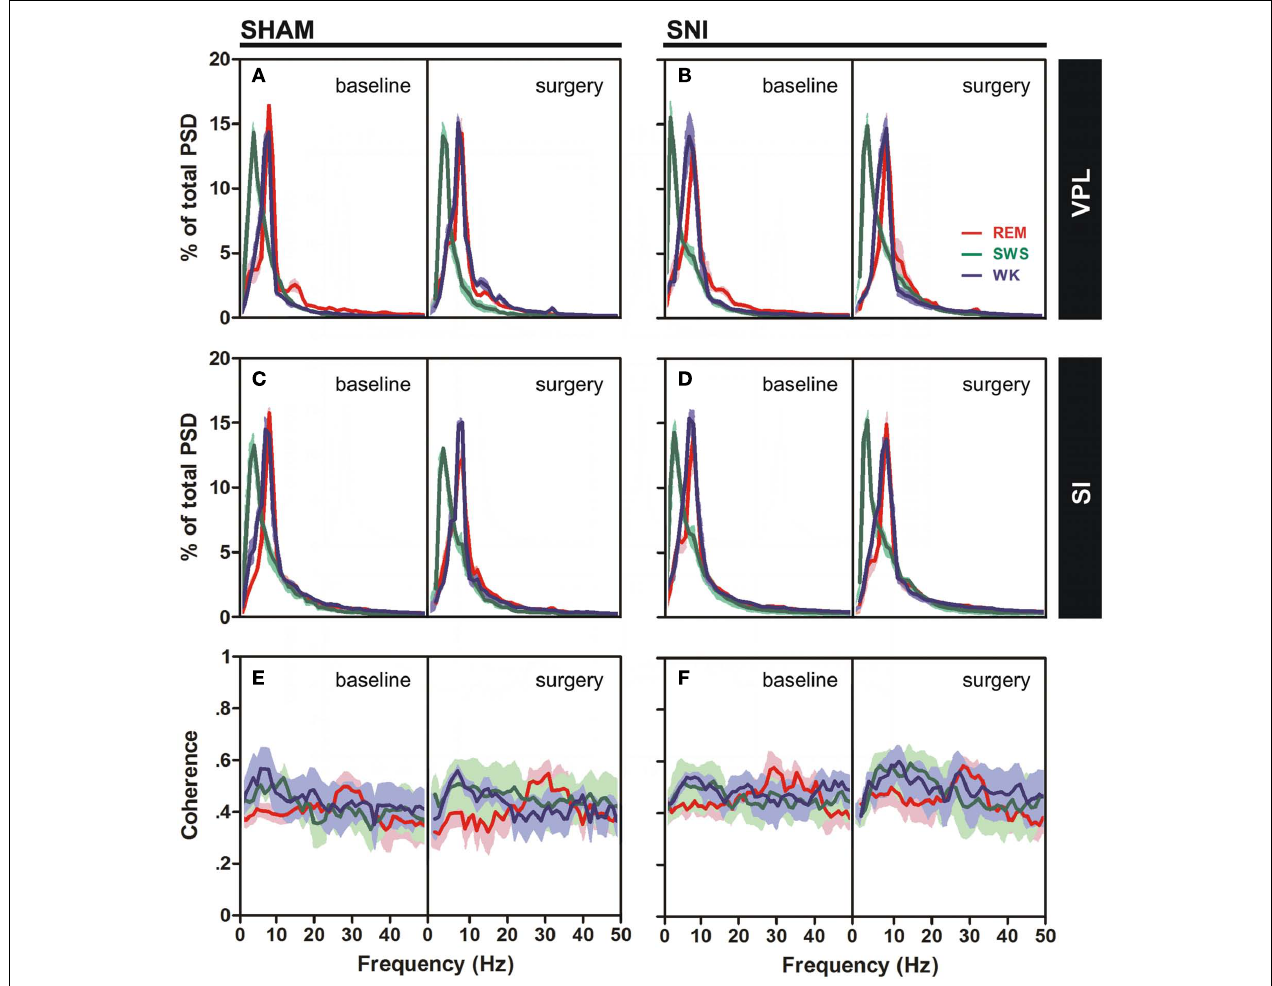
within the frequency range analyzed (1–50Hz) forVPL (A,B) and SI (C,D) channels. PSD showed that spectral power patterns were conserved across the experimental groups. (E,F) Coherence betweenVPL and SI LFPs showed similar levels of coherence activity across all experimental